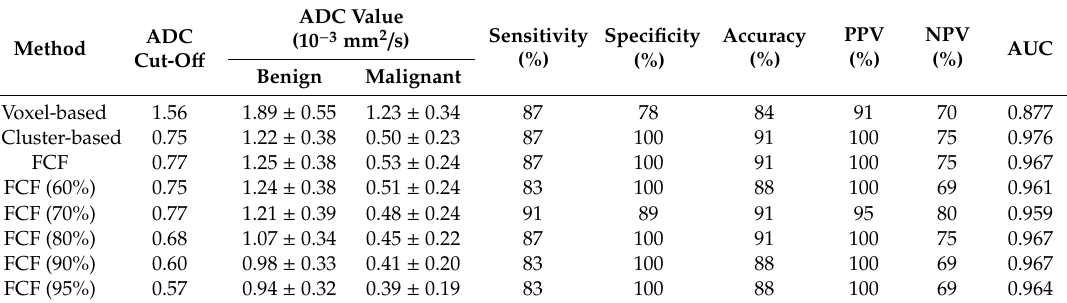
Table 2. The apparent diffusion coefficient (ADC) according to tumor malignancy in the voxel-based, cluster-based and Fit-Cluster-Fit models, applying different confidence thresholds to exclude uncertainties (60%, 70%, 80%, 90% and 95%). Clustered habitats were built based on the 5 th percentile of the artificially generated ADC distributions.